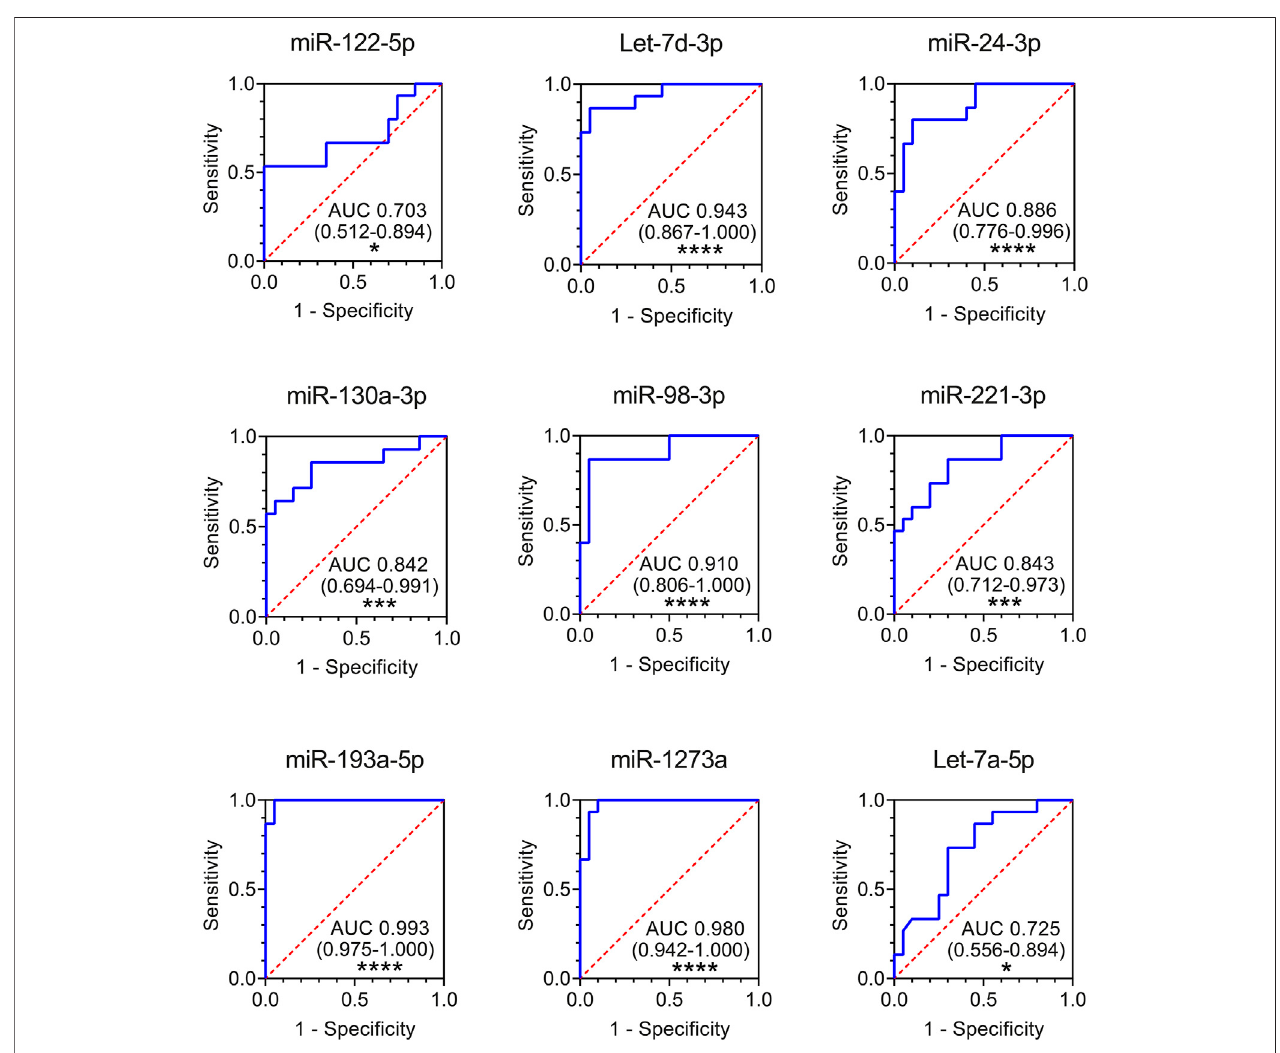
FIGURE 4 | ROC curves for comparing the ability of exosomal miR-122-5p, Let-7d-3p, miR-24-3p, miR-130a-3p, miR-98-3p, miR-221-3p, miR-193a-5p, miR- 1273a, and Let-7a-5p to discriminate ARDS patients from HSs. Area under the curves (AUCs) and 95% con fi dence interval (CI) of AUC are indicated. * p < 0.05, ** p < 0.01, *** p < 0.001, and **** p < 0.0001. HS n (cid:2) 20 biologically independent samples; ARDS n (cid:2) 15 biologically independent samples (validation